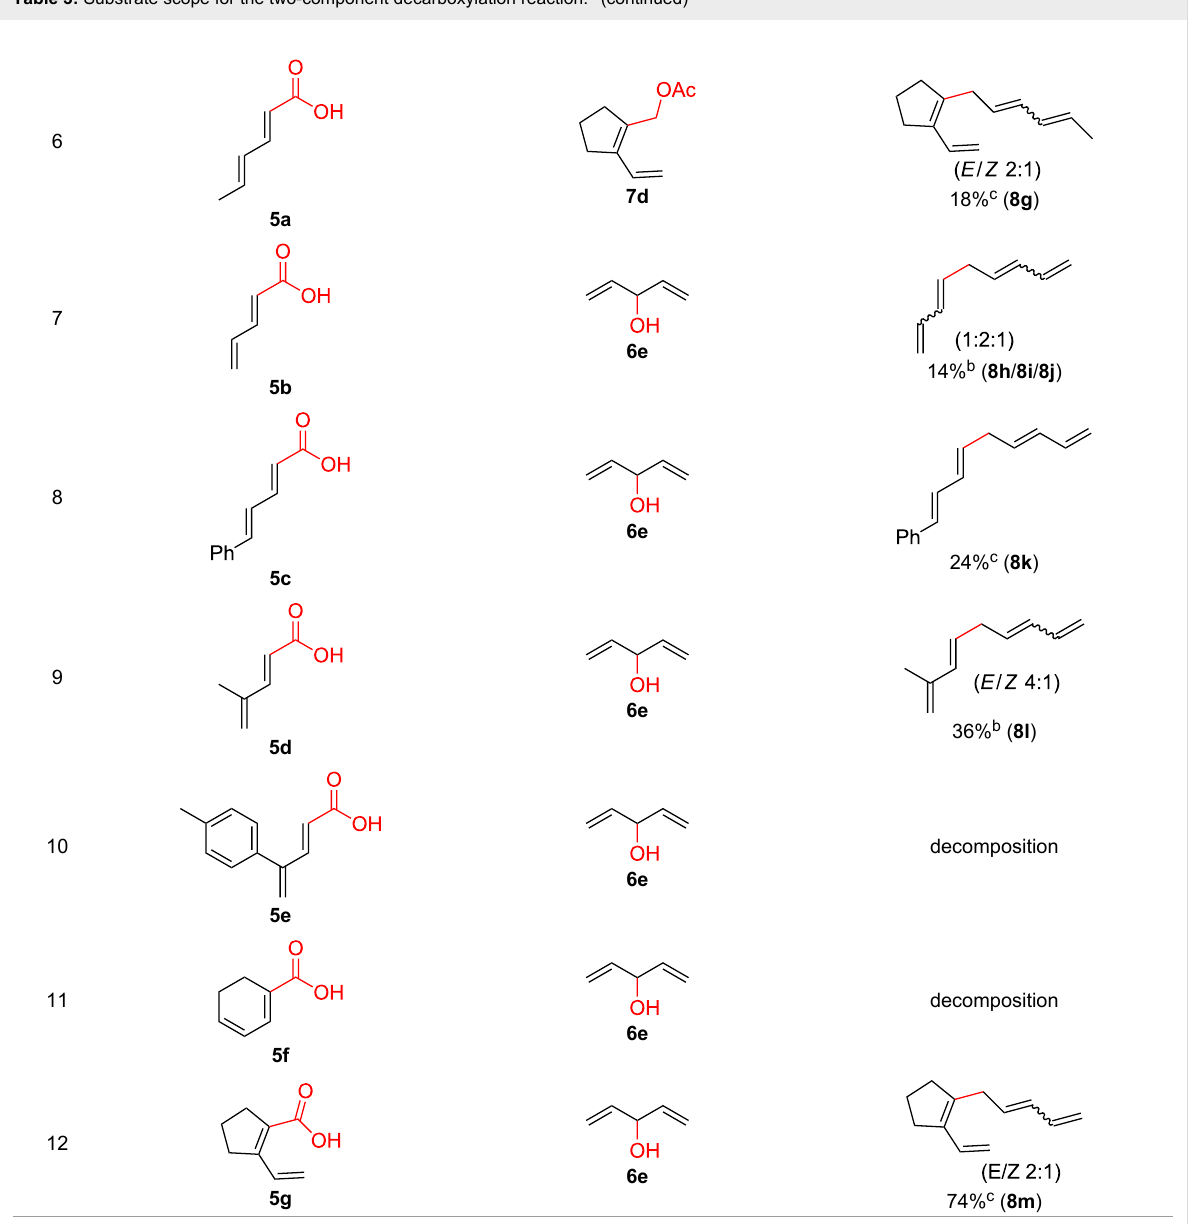
Table 3: Substrate scope for the two-component decarboxylation reaction. a